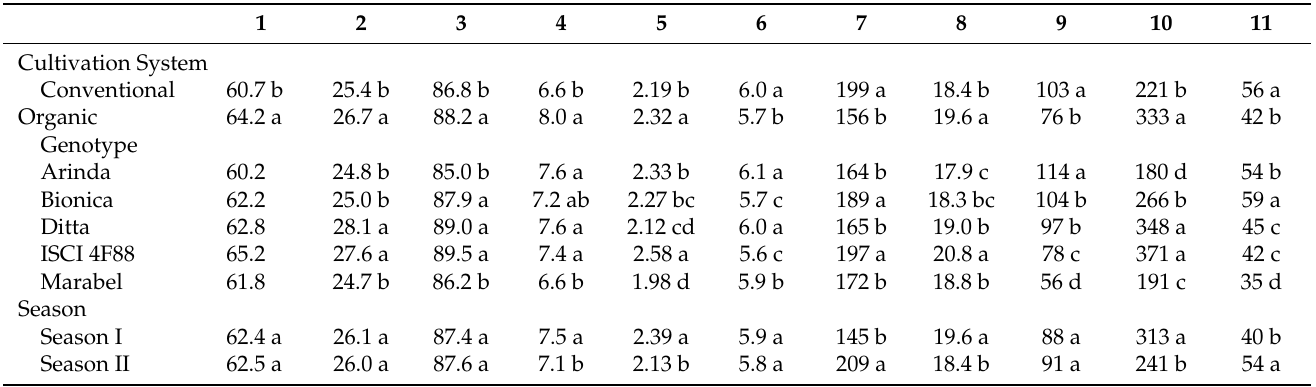
Table 4. Physico-chemical and nutritional quality of early potatoes as affected by cultivation system, genotype, and season.